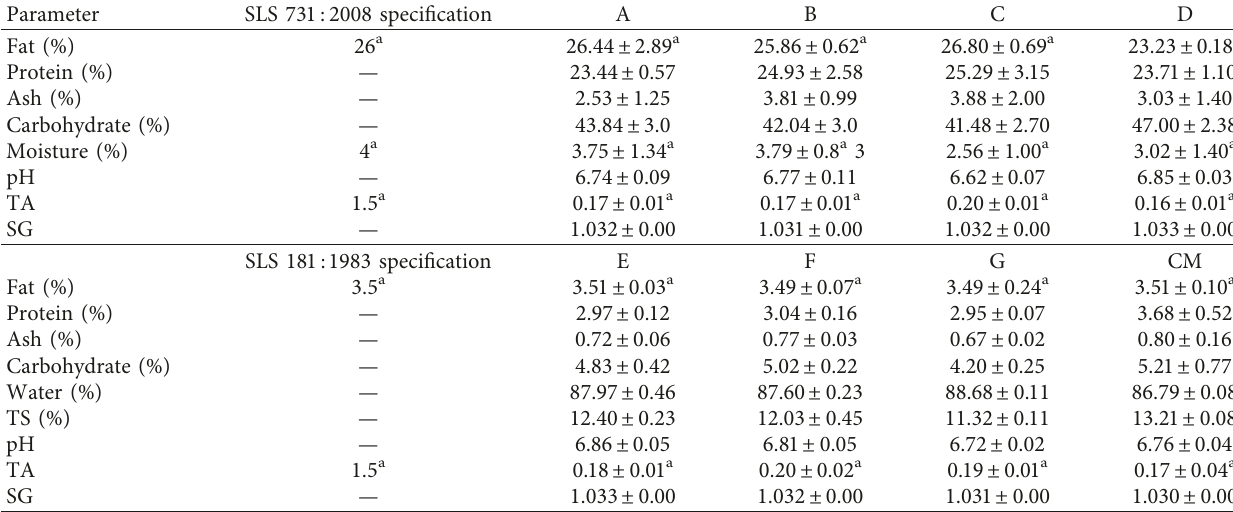
Table 2: Comparison between physicochemical parameters of samples with Sri Lankan standards.